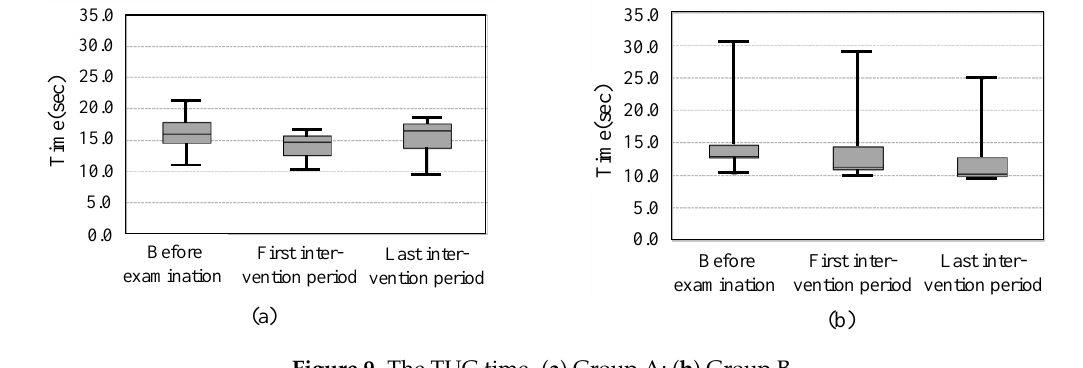
Figure 6. The TUG time. ( a ) Group A; ( b ) Group B. Figure 9. The TUG time. ( a ) Group A; ( b ) Group B.